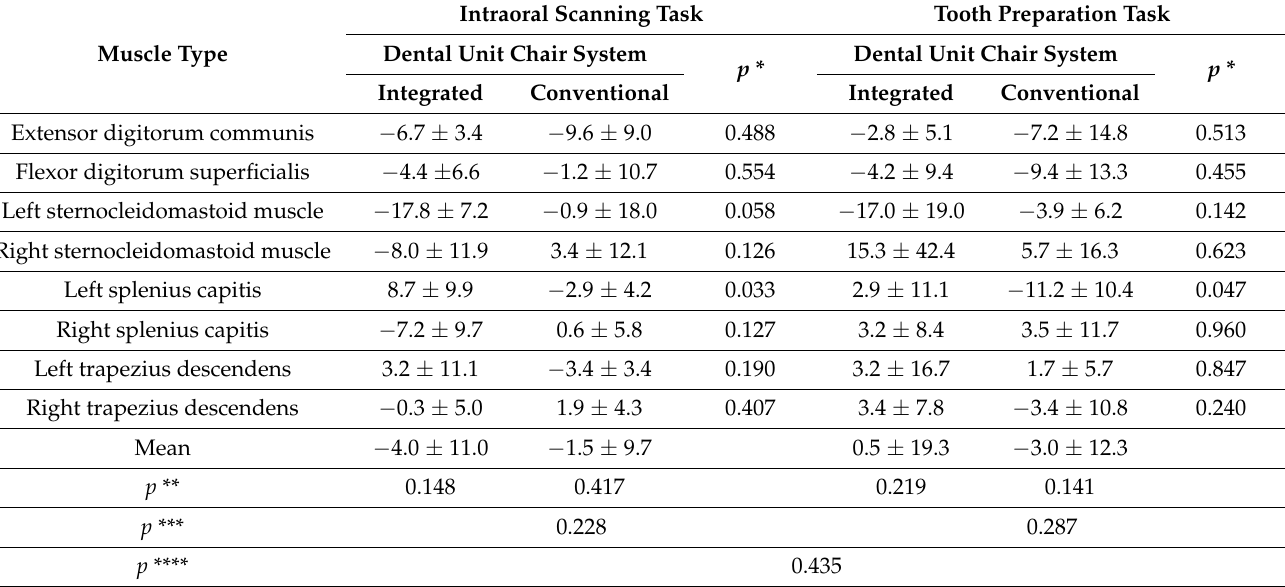
Table 2. Comparison of mean muscle fatigue (%) according to muscle type and dental unit chair